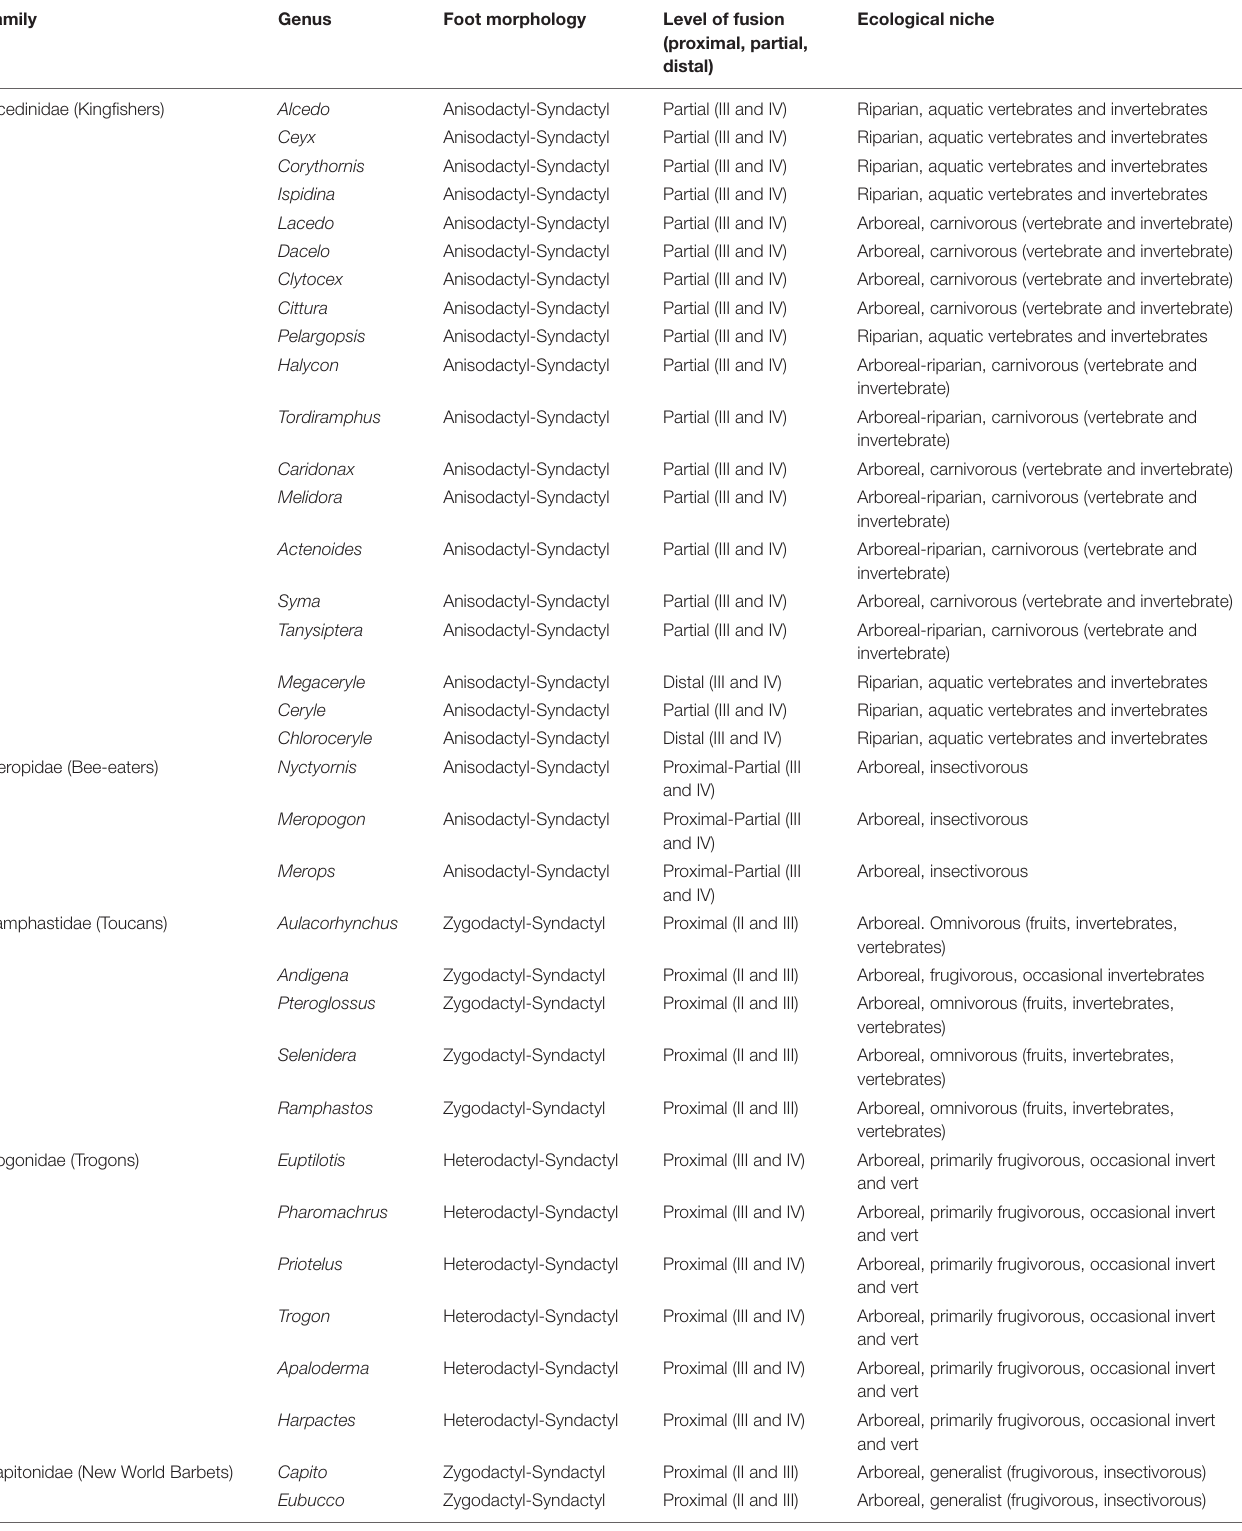
TABLE 2 | List of 14 neornithine families in which syndactyly occurs.